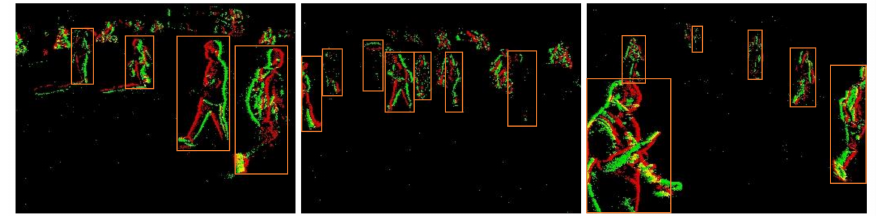
Figure 4. Some examples and pedestrian annotations in the Pedestrian-SARI (Shanghai Advanced Research Institute) dataset. All event frames are constructed by the NSTS–SAE